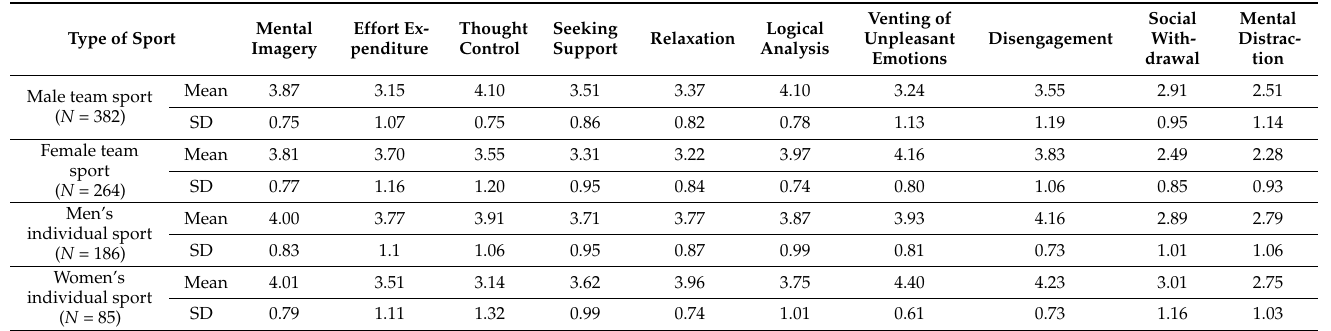
The highest first-order scores for coping relative to sport type were as follows (Table 5). Table 5. First-order coping scores compared to the type of